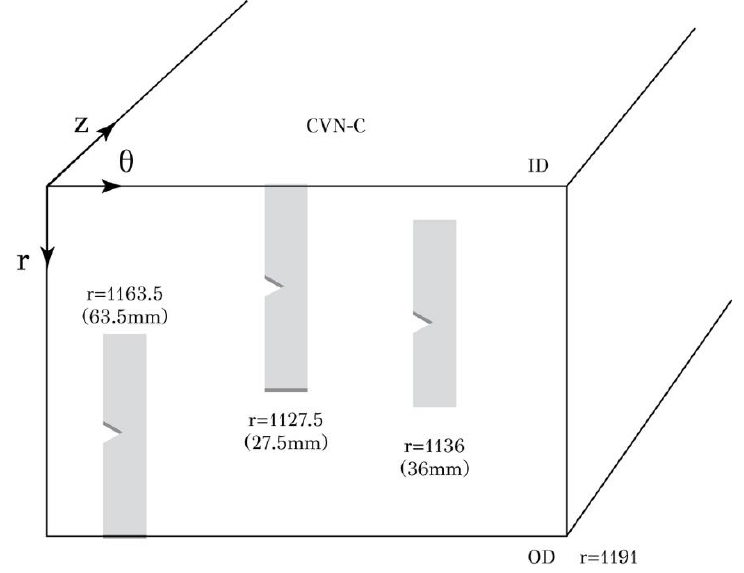
Figure 5. Positions of the CVN-C specimens relative to ID and OD.